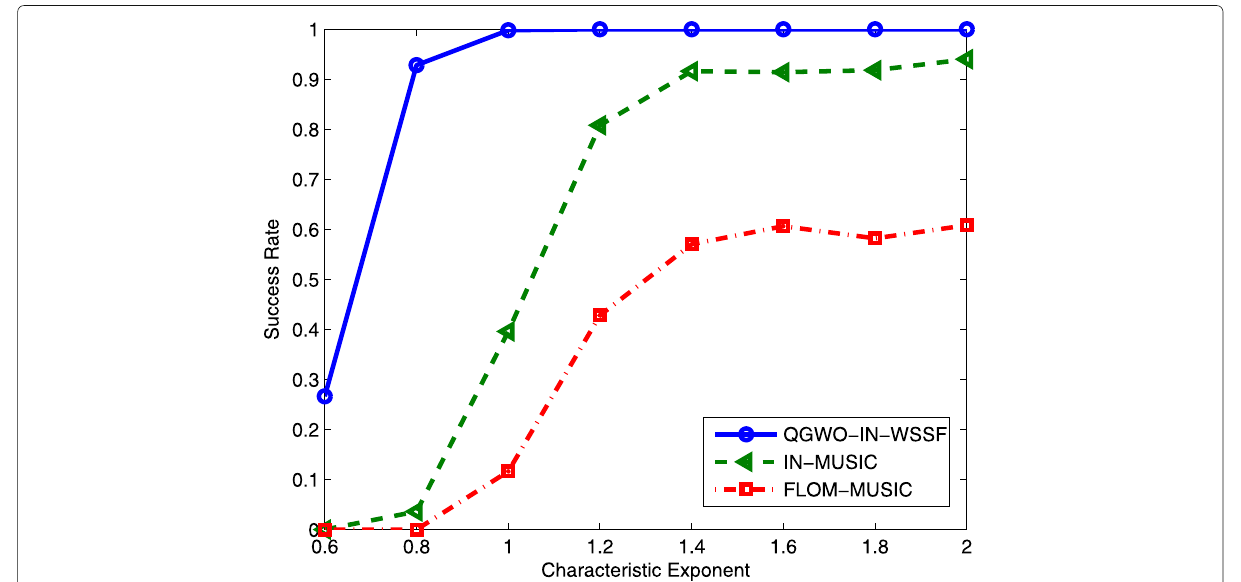
Fig. 5 Success rate curves versus characteristic exponent for two independent sources with GSNR = 20dB